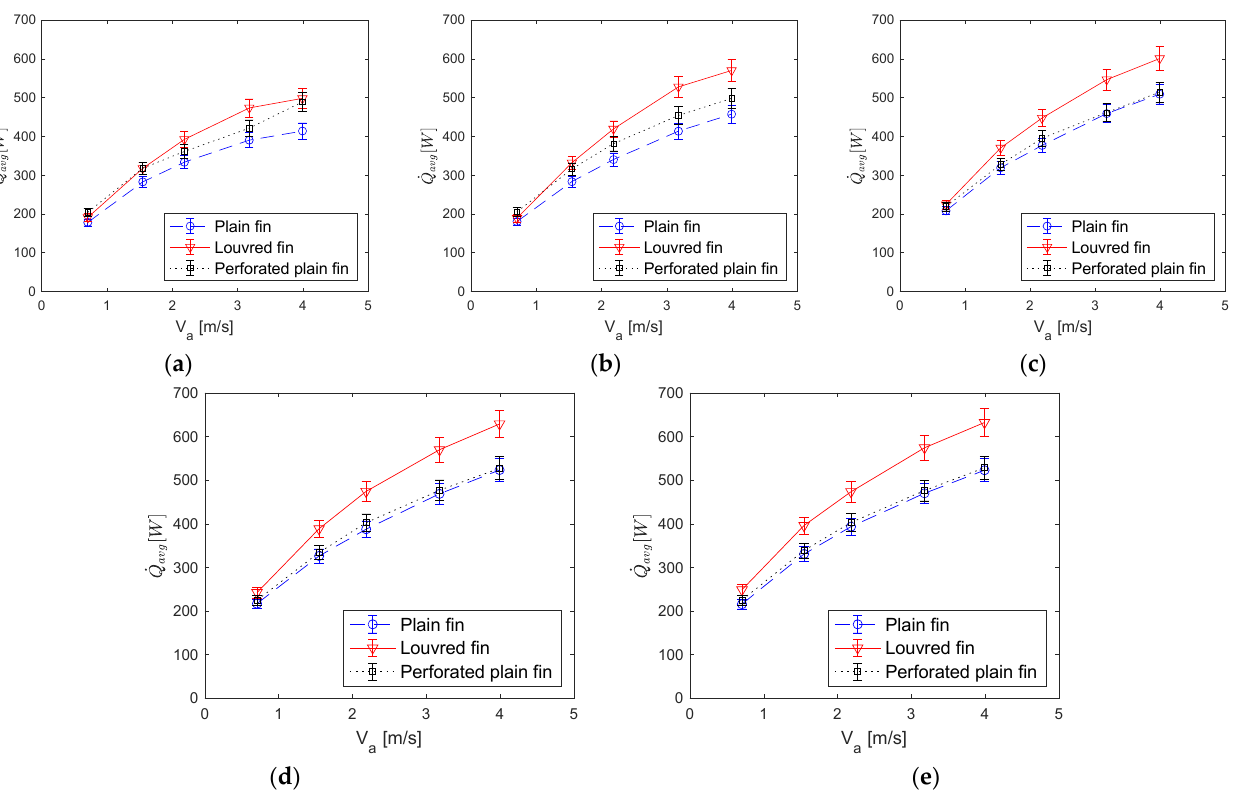
Figure 5. Variation of ( Q avg [ W ]) against V a for various heat exchangers; ( a ) for water flow rate 0.12 m 3 /h, ( b ) for water flow rate 0.18 m 3 /h, ( c ) for water flow rate 0.24 m 3 /h, ( d ) for water flow rate 0.3 m 3 /h and ( e ) for water flow rate 0.36 m 3 /h.